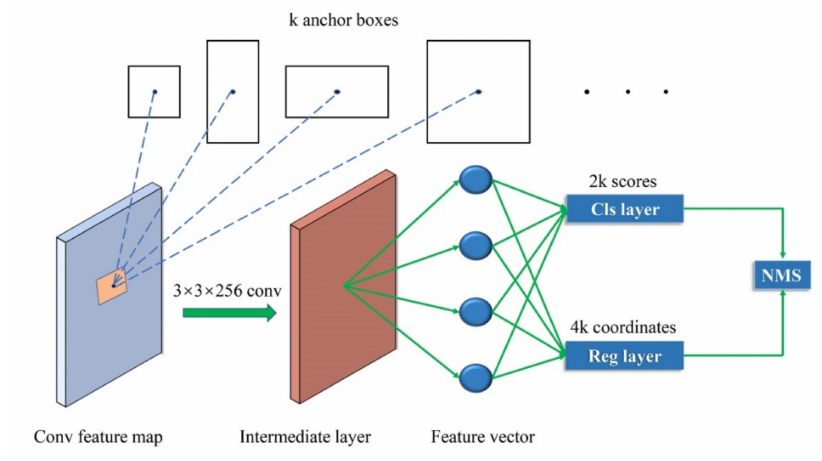
Figure 8. The structure of the RPN.